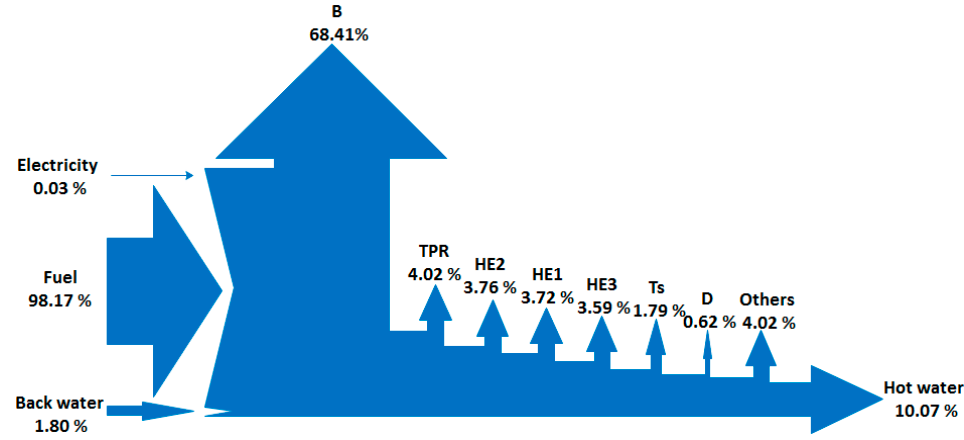
Figure 7. Exergy balance of the whole system.